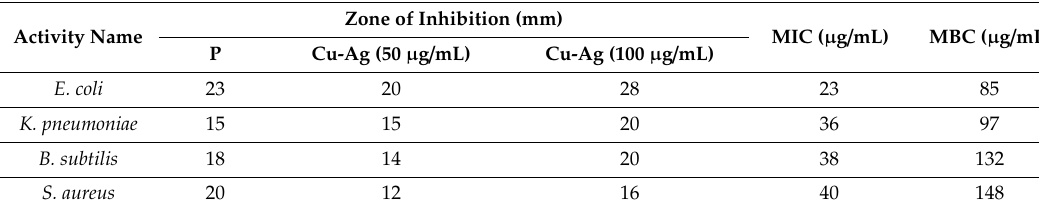
Table 1. The comparison of antibacterial studies of prepared nanostructures with gram-negative and gram-positive bacterial strains.